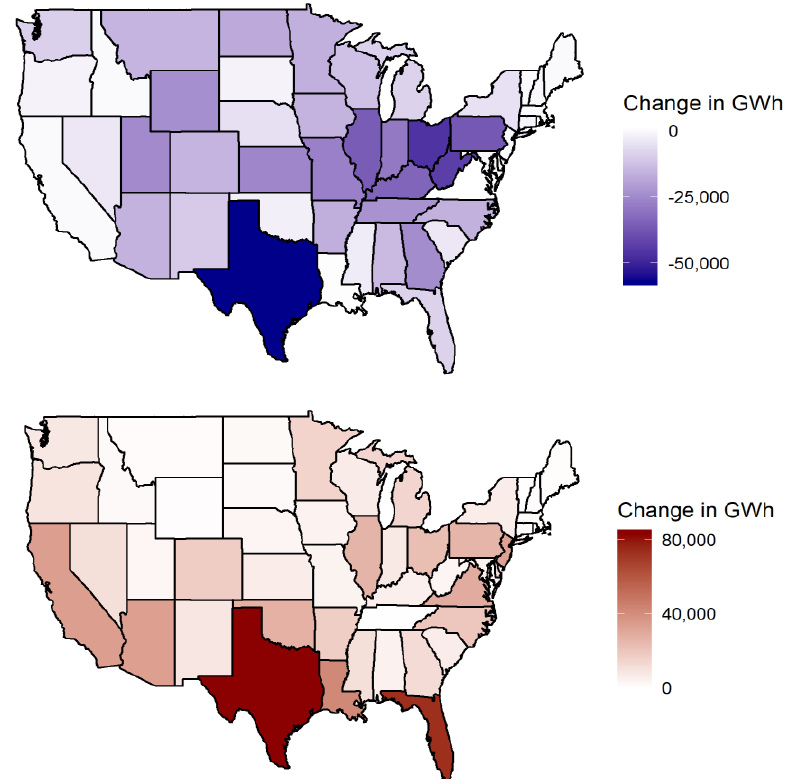
Figure 7. Decrease in coal generation (top) and increase in natural gas generation (bottom) from $50/ton carbon tax.